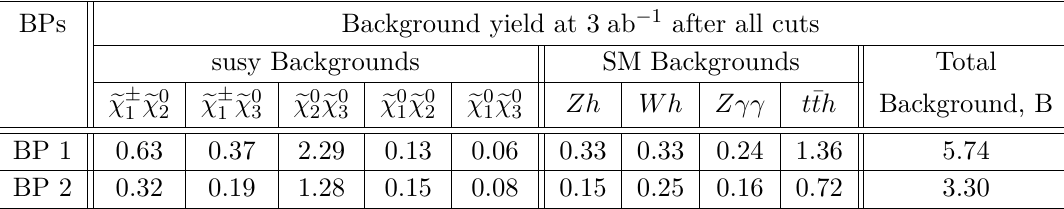
Table 24. The background yield at 14 TeV with 3 ab − 1 of integrated luminosity after the cut-based analysis for the two benchmark points in b-tag